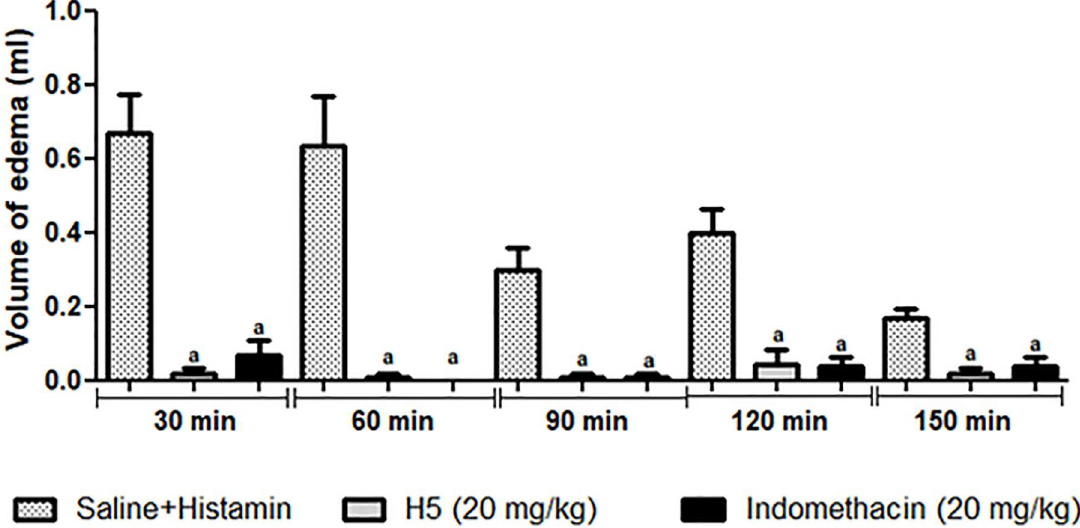
Fig 13. Effect of H5 (20 mg/kg, p.o.) on paw edema induced by histamine in mice. The sham group was treated only with saline, whereas the control group received saline and histamine. Values are expressed as the mean ± S.E.M. (n = 6, per group), where a indicates p < 0.05, significantly different from the control group, according to ANOVA, followed by Tukey’s post-test.